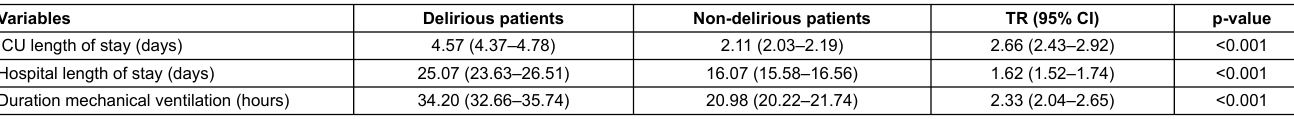
Table 4: Associations between delirium and ICU length of stay, hospital length of stay and mechanical ventilation. Variables Delirious